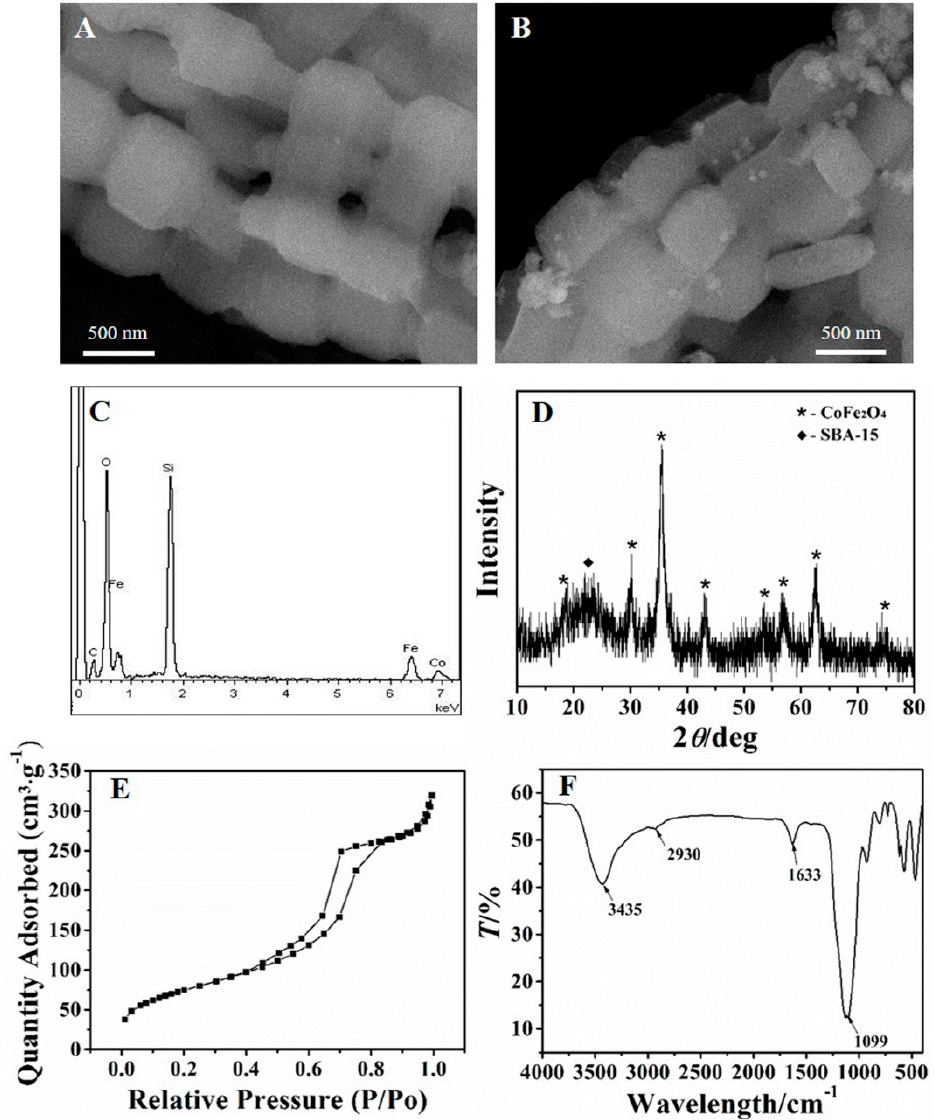
Figure 2. SEM images of SBA–15 ( A ) and CoFe 2 O 4 /SBA–15 ( B ); EDS spectrum of CoFe 2 O 4 /SBA– 15 ( C ); XRD pattern ( D ), BET analysis ( E ), and FTIR spectrum ( F ) of NH 2 –CoFe 2 O 4 /SBA–15. The XRD pattern was further used to analysis the NH 2 –CoFe 2 O 4 /SBA–15. As shown in Figure 2D, the dispersion peak nearly 2 θ = 23 ◦ was attributed to the amorphous SBA–15.